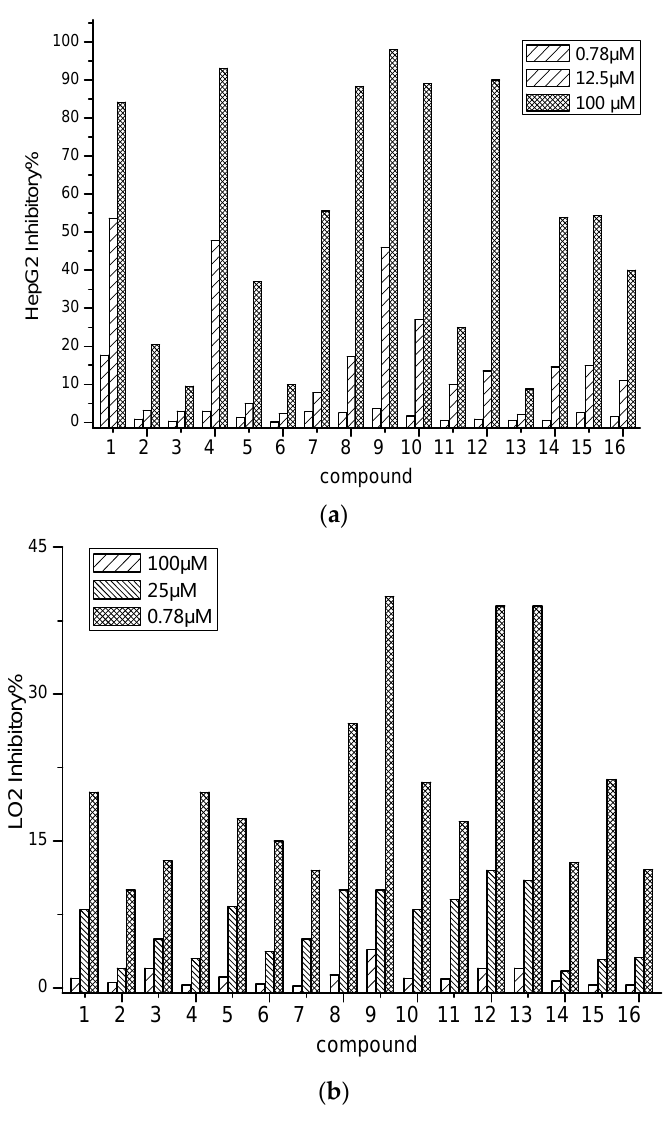
Figure 1. Compounds 1 – 16 inhibitory on HepG2 and LO2 in vitro: ( a ) the inhibitory rate on HepG2; and ( b ) the inhibitory rate on LO2. Statistical treatment: SPSS 17.0 Statistical software for data processing and statistical scoring Analysis. The experimental data are expressed as mean ± standard deviation (mean ± SD). Normality and variance homogeneity test are carried out to satisfy the normal distribution and variance. Univariate ANOVA was used to compare the homogeneity. p < 0.05. There was significant difference between groups.